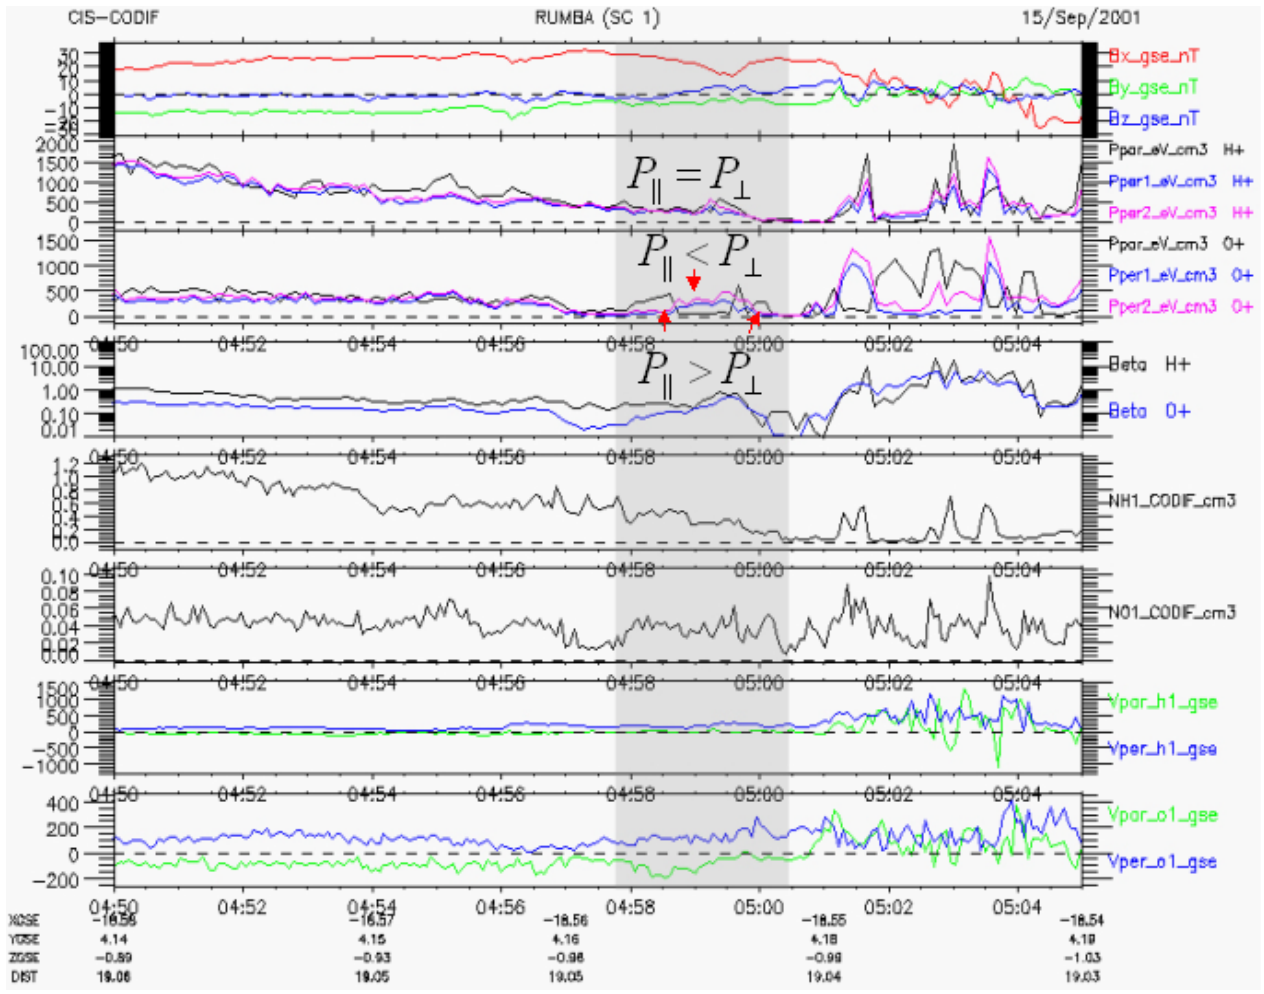
Fig. 6. 3-D momenta of proton and oxygen ions from C1. (a) the components of magnetic field. (b) and (c) are the pressure components. (d) is the beta value. (e) and (f) are the densities. (g) and (h) are bulk